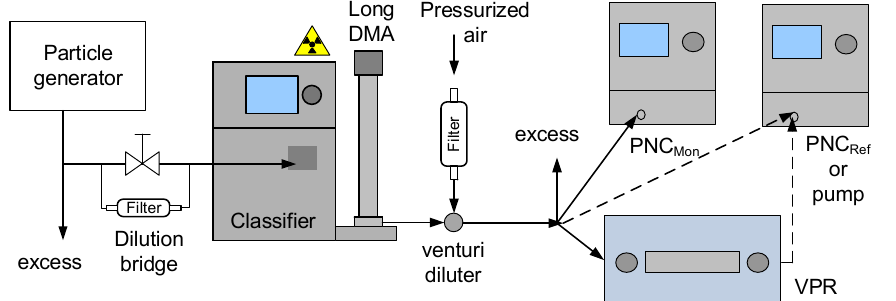
Figure 3. Experimental setup for the monodisperse calibration of the VPR. DMA = differential mobility sizer; PNC = particle number counter; VPR = volatile particle remover.